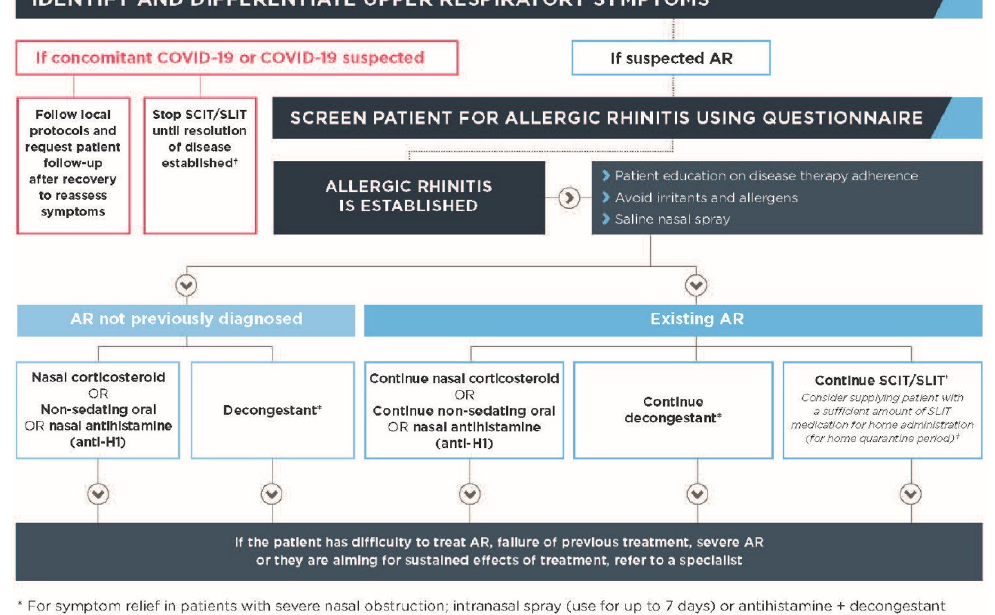
Figure 3. A framework for managing allergic rhinitis in primary care.